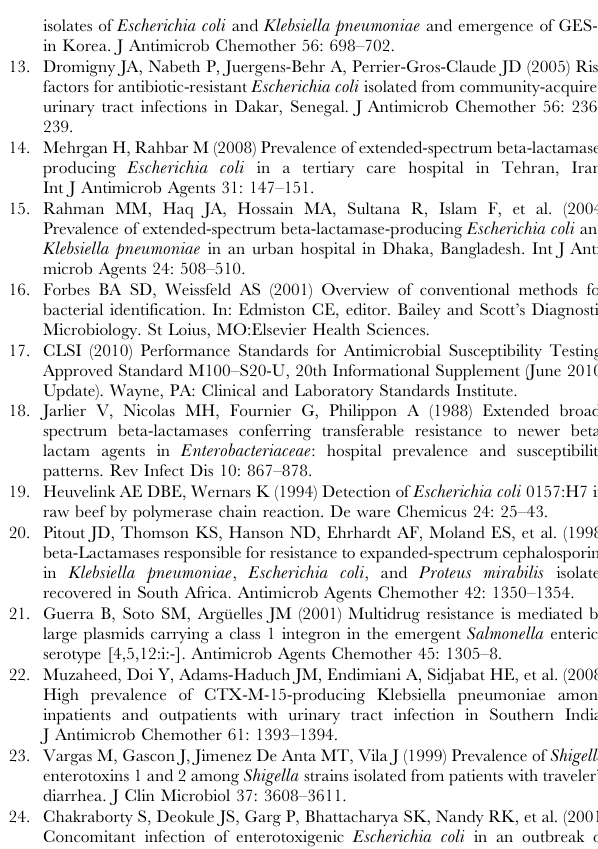
Table S1 Plasmid profile analysis of ESBL-producing E .